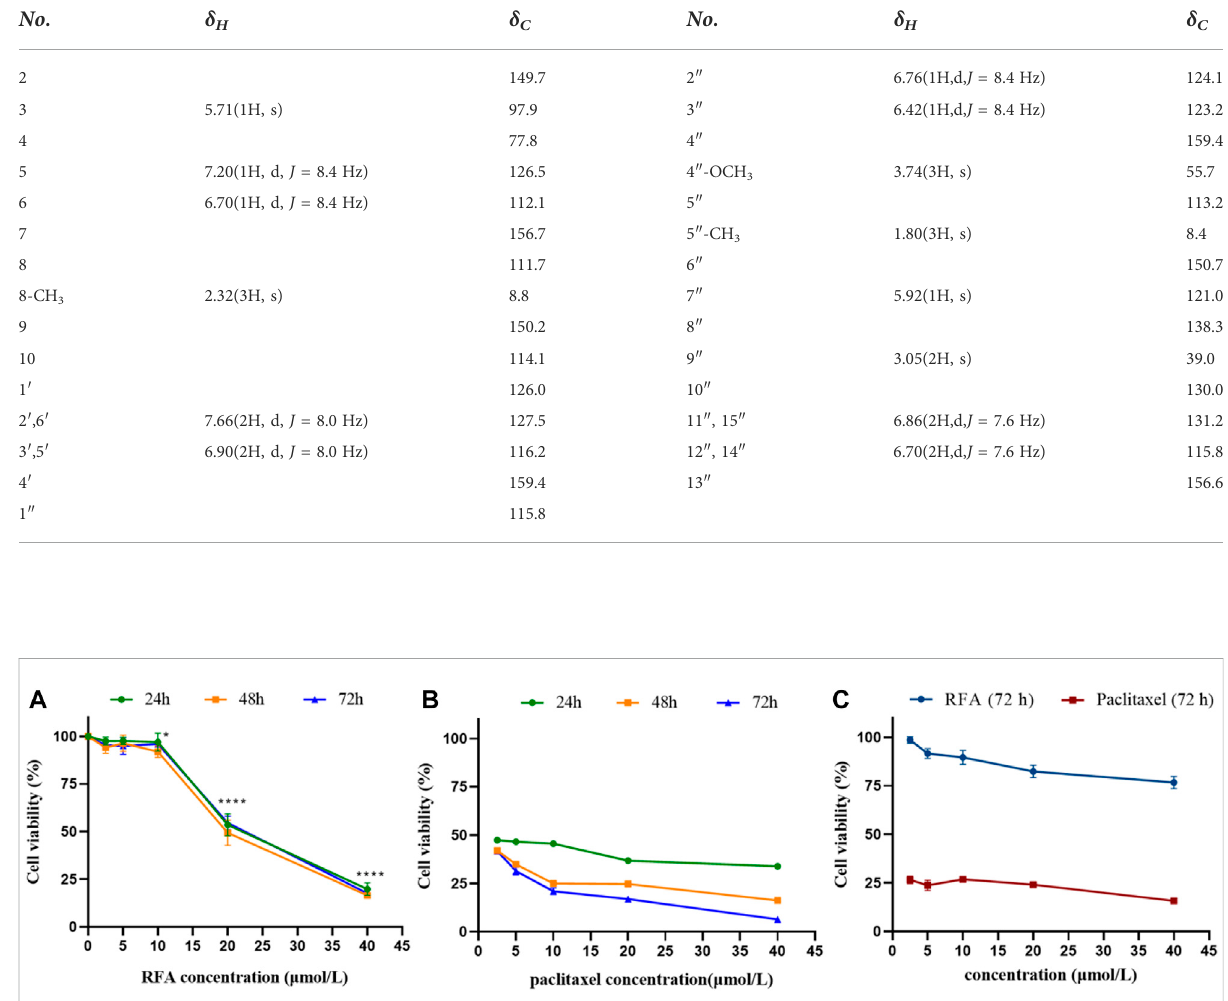
TABLE 1 1 H-NMR 和 13 C-NMR data of RFA.